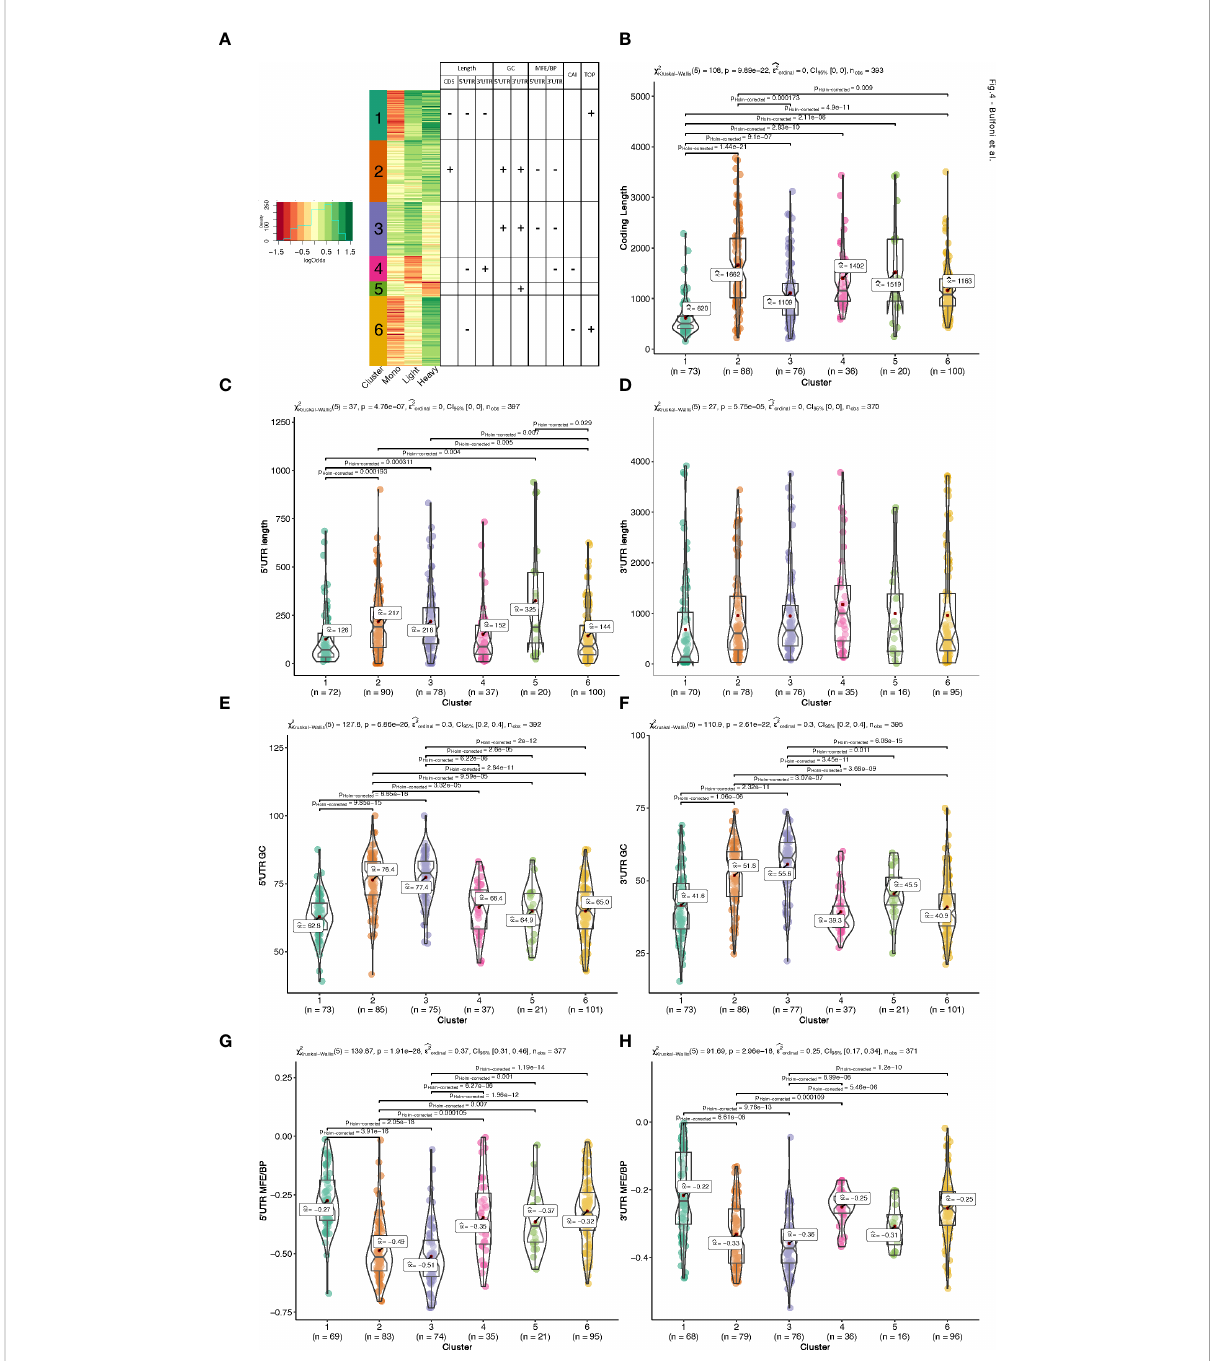
FIGURE 4 Clustering and mRNA features analysis. (A). Heatmap of the log2 ratios between the average TPM of each differentially translated gene in high- over low- glucose. An unsupervised model clustering algorithm was used to cluster the differentially translated genes into six groups represented here with the coloured vertical bar at the left side of the fi gure. Colours range from dark red when genes are less represented in a polysome fraction to dark green when overrepresented in a polysome fraction in high glucose condition. The table summarizes the variations observed for the different features presented in (B-H) each box plot corresponds to an analysis of a particular feature for all the 6 clusters of translation behaviour. The Kruskal-Wallis H-test is used for all the group comparisons to test for median differences with the Dunn test for each pairwise comparison. The test statistics are shown in the subtitle and each signi fi cant pairwise comparison (corrected for multiple testing) is plotted only for signi fi cant pairwise